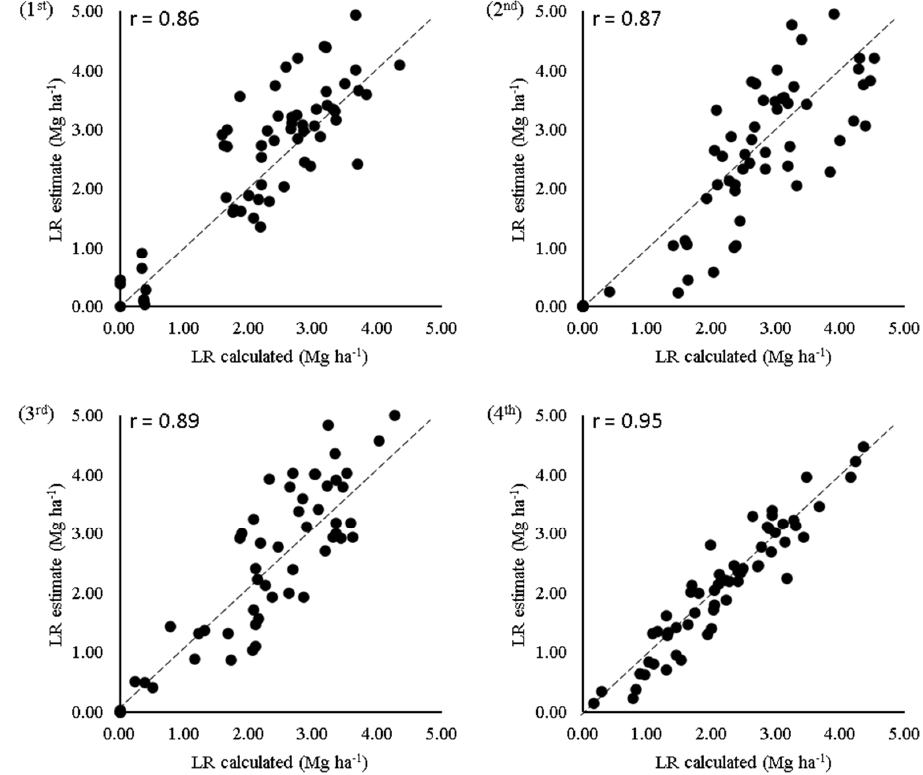
Figure 7. Correlations between the calculated liming recommendation (LR) (based on chemical characteristics obtained by conventional laboratory techniques) and the liming recommendation (LR) estimated using PLSR models (based on the chemical characteristics obtained by the PLSR models) for four soil assessments (1 st = first assessment; 2 nd = second assessment; 3 rd = third assessment; 4 th = fourth assessment).